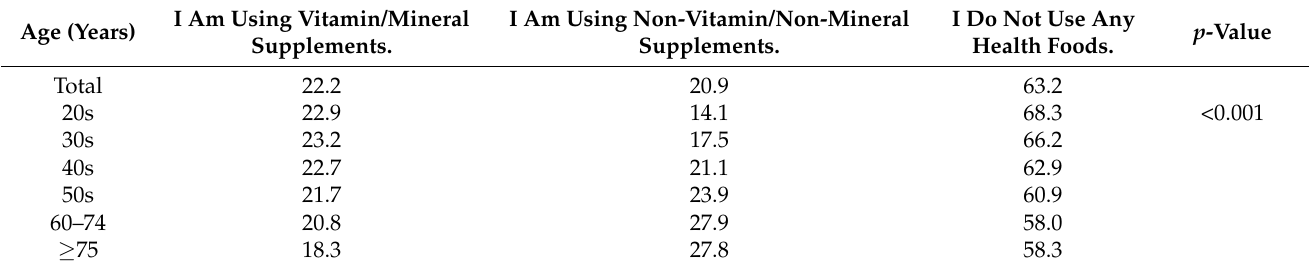
Table 4. Prevalence of health food